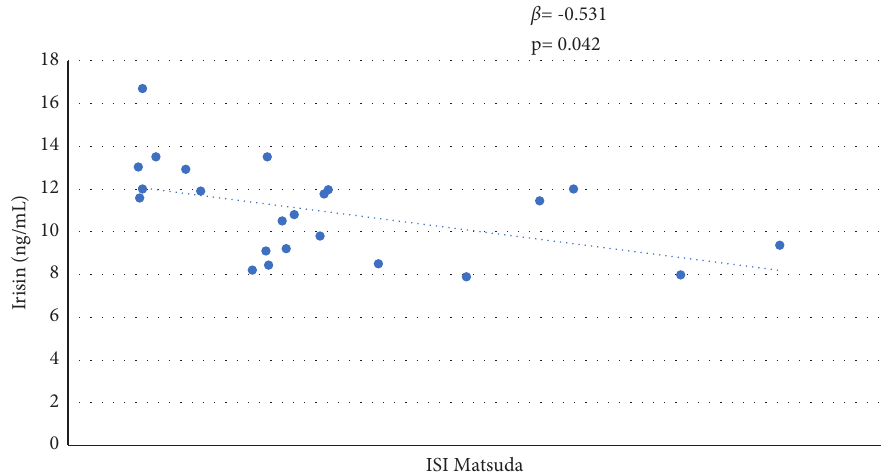
Figure 2: Correlation between irisin and ISI-Matsuda in patients with Klinefelter